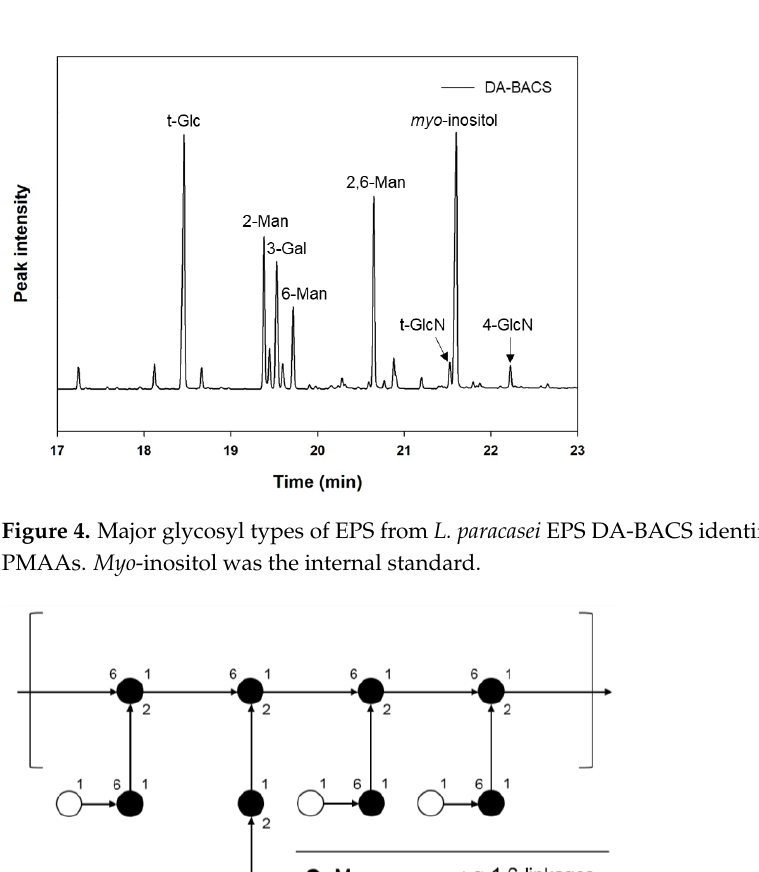
Figure 5. Schematic representation of the proposed structure of EPS from L. paracasei EPS DA-BACS.